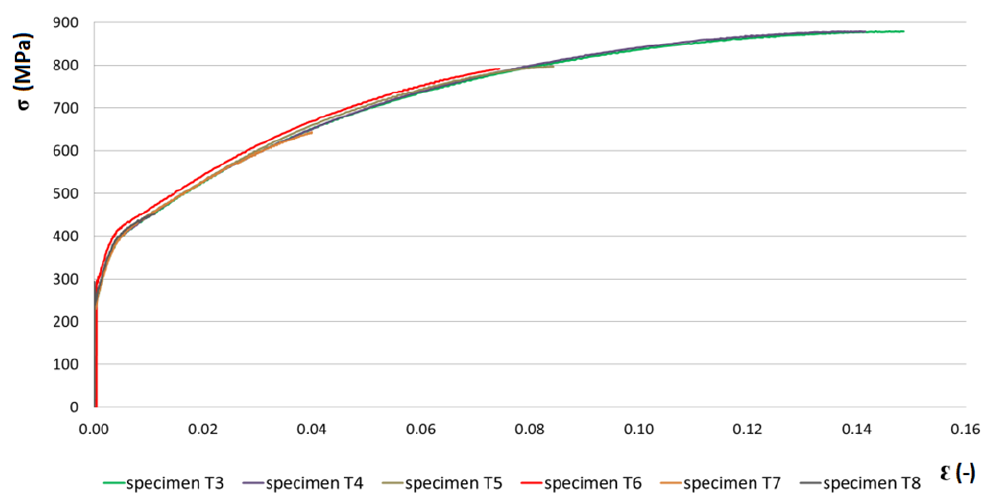
Figure 6. Stress–strain curves of TRIP steel for specimens Figure 6. Stress – strain curves of TRIP steel for specimens T3 – T8.